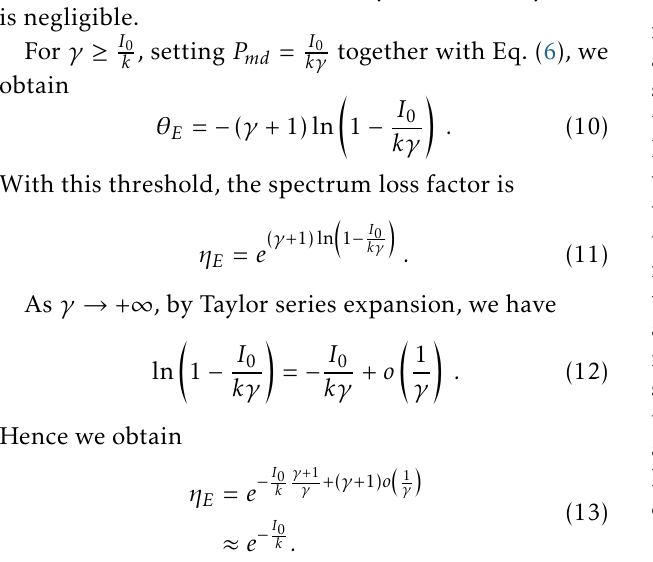
0 = 0 . 5 N 0 , N 0 , 2 N 0 , 5 N 0